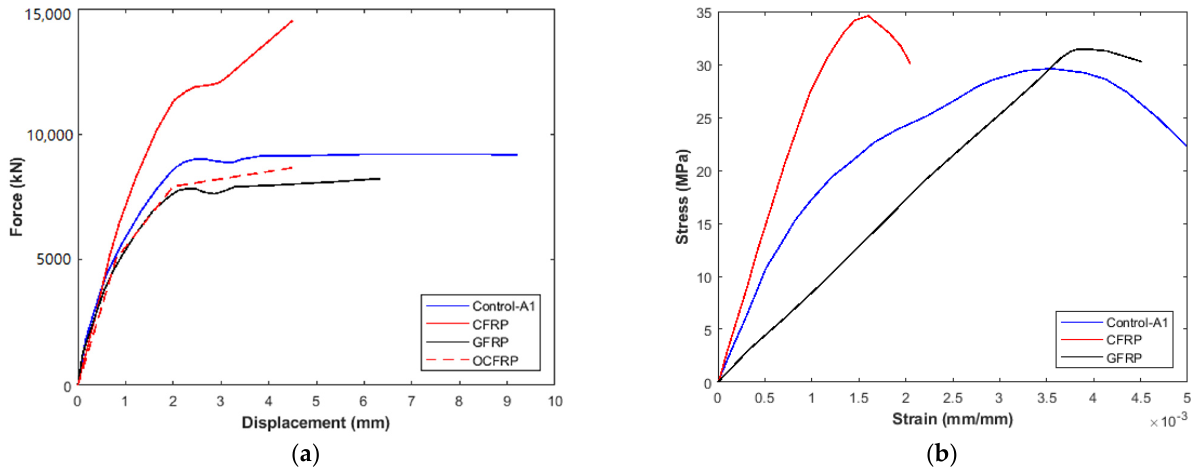
Figure 7. Group A ( a ) Load-Displacement diagram ( b ) Stress-Strain Diagram.